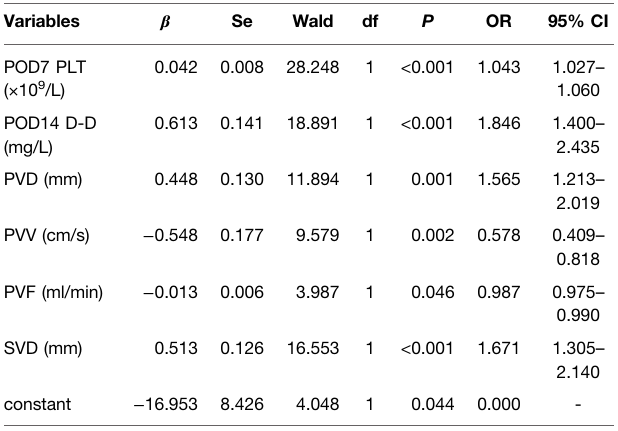
TABLE 4 | Logistic multivariate regression analysis of PVST after splenectomy.